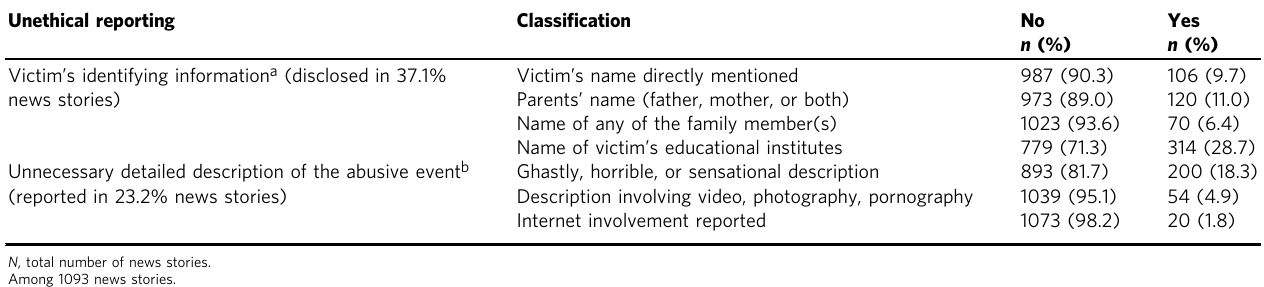
Table 2 Unethical reporting in daily newspapers of Bangladesh, 2017 ( N = 1093).